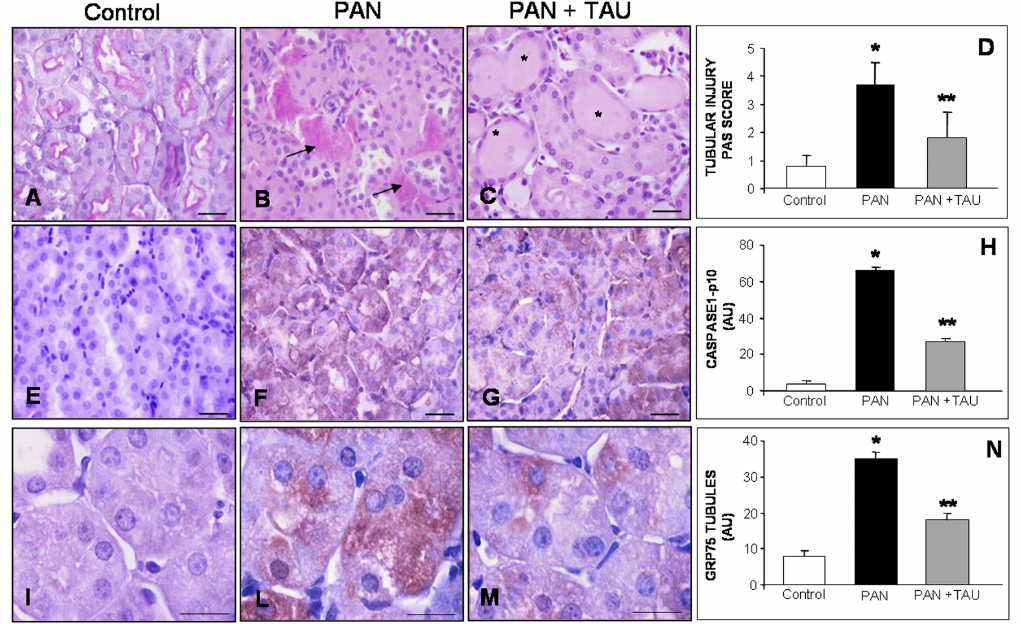
Figure 5. Tubular Inflammation and Mitochondrial Stress. ( A – C ) PAS histopathology, ( E – G ) activated caspase 1-p10 and ( I – M ) mitochondrial chaperone GRP75 stainings in the proximal tubules of ( A , E , I ) control rats, ( B , F , L ) PAN nephrotic rats and ( C , G , M ) PAN rats orally pre-treated with TAU. ( A – C ) The arrows identify the proteinaceous casts and the asterisks show the tubular dilatation. Bar represents 20 µm. Tubular damage expressed as ( D ) tubular injury score, ( H ) quantitative estimation of caspase 1-p10, ( N ) and GRP75 immunostainings, expressed as arbitrary units. * p < 0.05 statistically significant versus control group; ** p < 0.05 significant versus PAN group.